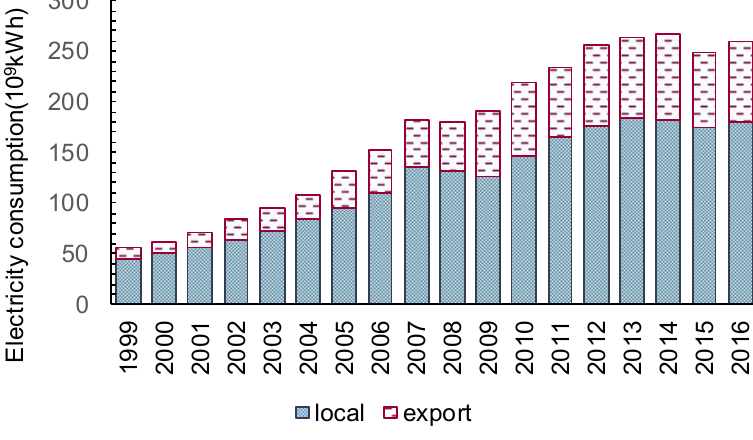
Figure 5. Electric consumption in Shanxi Province over 1999–2016.